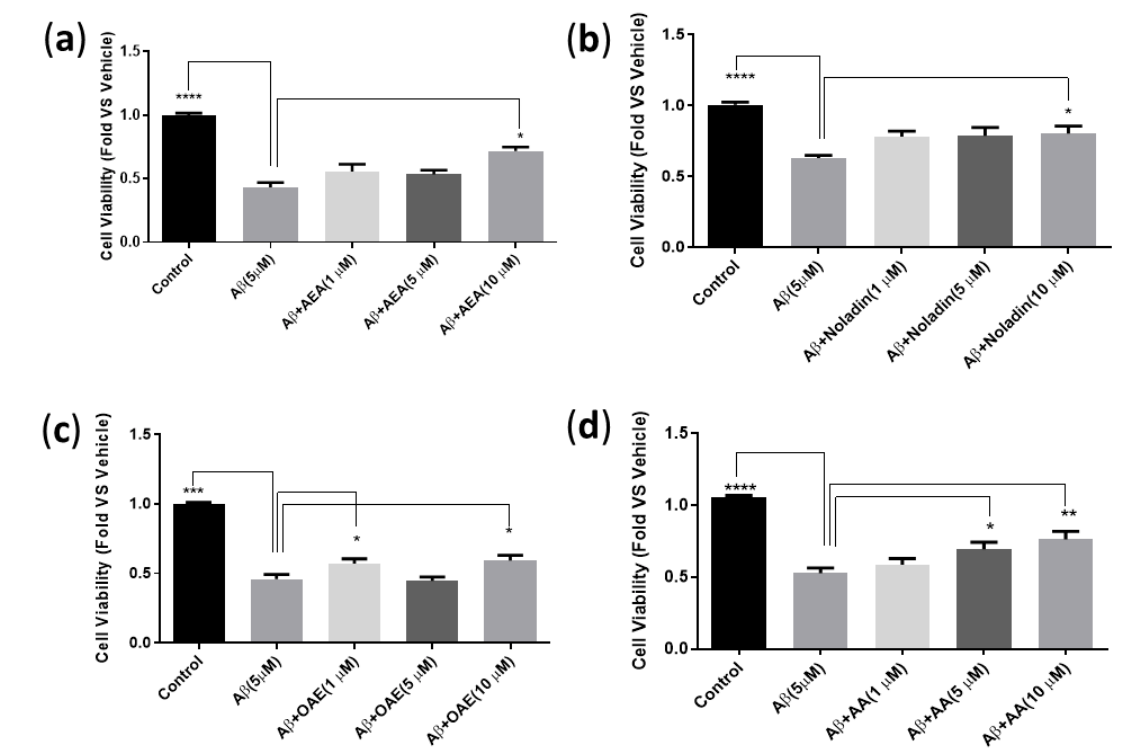
Figure 2. Effect of at 1, 5, 10 μ M endocannabinoids and AA, against A β 42 (5 μ M) toxicity on HT22 cells. Cells were treated with A β 42 in the absence or presence of AEA ( a ), Noladin ( b ), OAE ( c ), and AA ( d ), compared to the untreated Control group. Cell viability was determined via MTT assay. A one-way ANOVA with Dunnett’s multiple comparisons performed to establish significance between groups ( α = 0.05 *, 0.01 **, 0.001 ***, 0.0001 ****). The results are shown as the average ± standard error of the mean (SEM). The data is representative 4 independent experiments, each with 4 technical replicates.